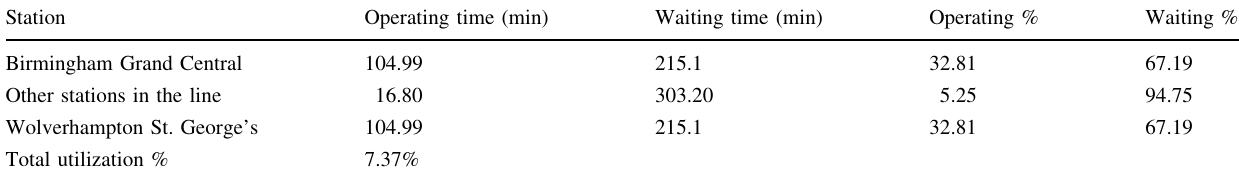
Table 11 Operating and waiting times of the system during super off-peak hours in anticlockwise direction